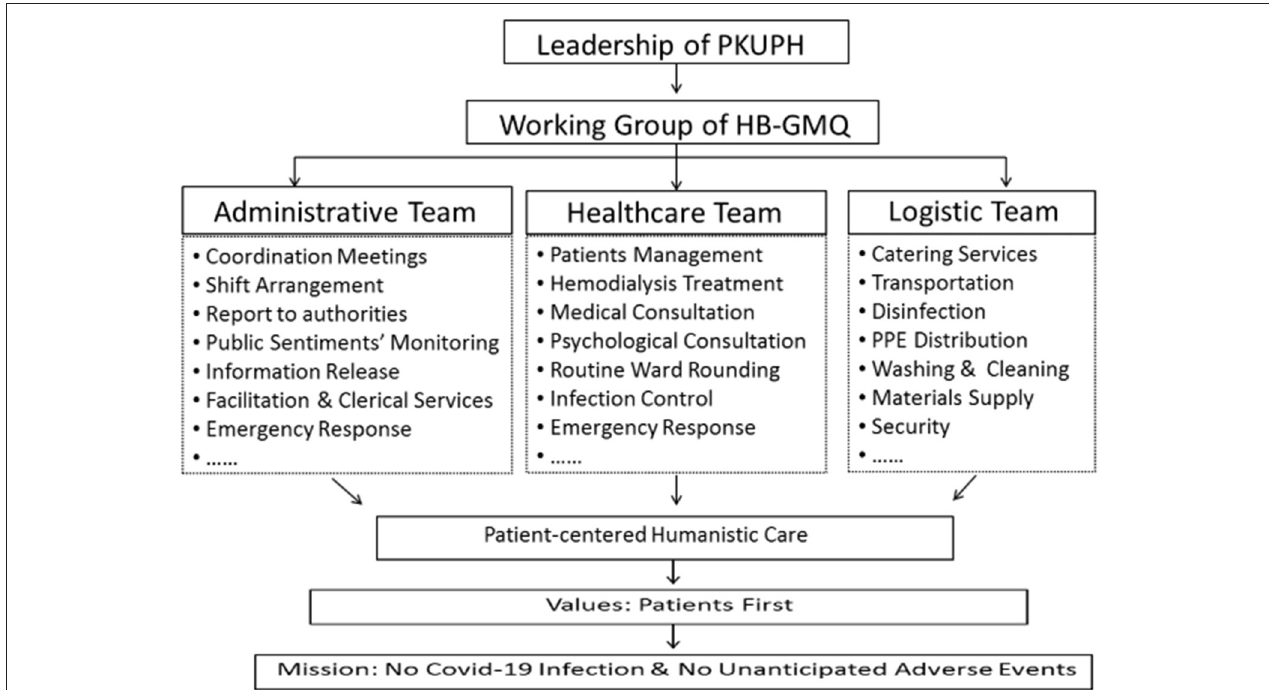
FIGURE 1 | Organizational arrangement of PKUPH working group of